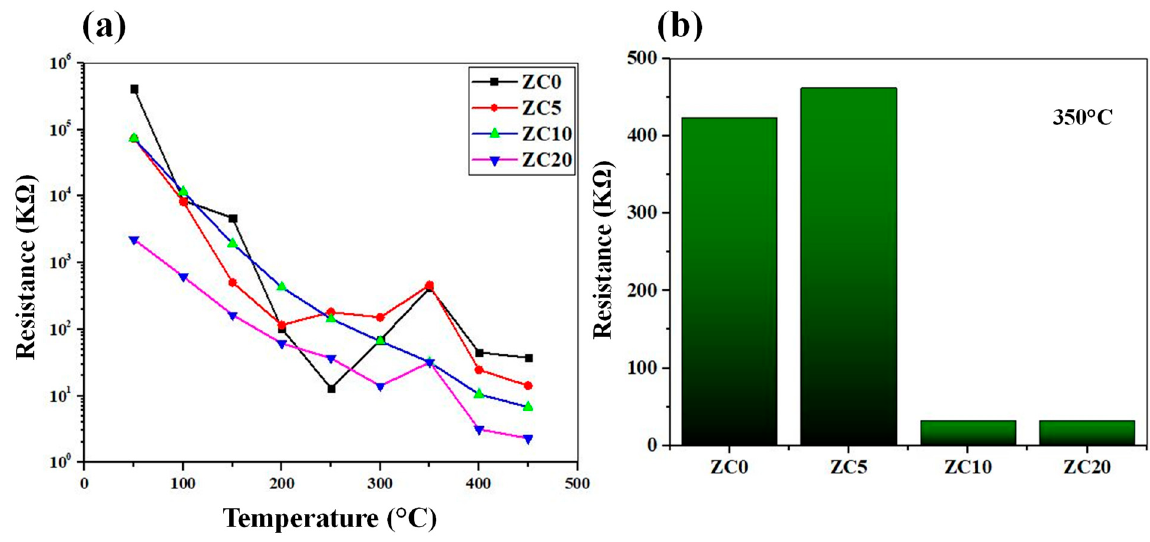
Figure 8. ( a ) Air resistance values of different gas sensors as a function of temperature. ( b ) Air resistance of gas sensors at 350 °C.